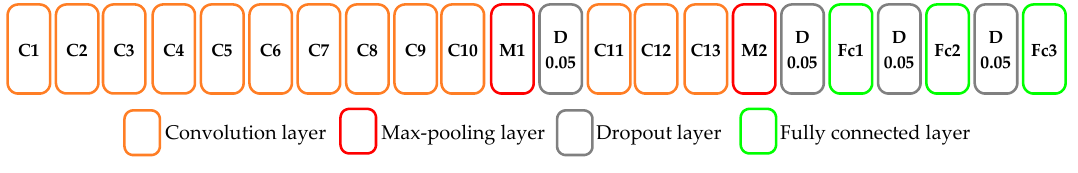
Figure 5. Alphanumeric VGG net with dropout.